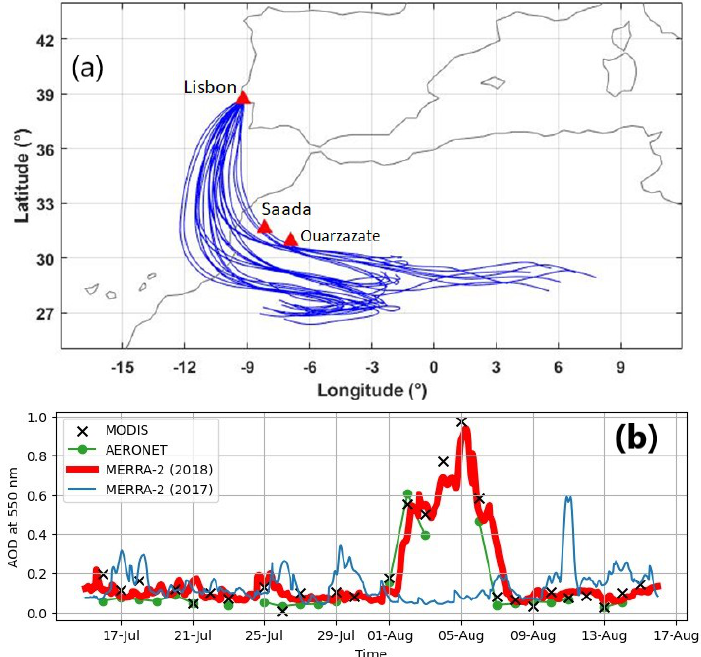
Figure 9. ( a ) Ensemble backward trajectories as simulated for 3 days (72 h) by the HYSPLIT model on 2 August 2018. The particles are initially released over Lisbon (38.7°N, 9.2°W) at 4 km above ground level. The red triangles indicate the initialization site (Lisbon) and the observation sites in